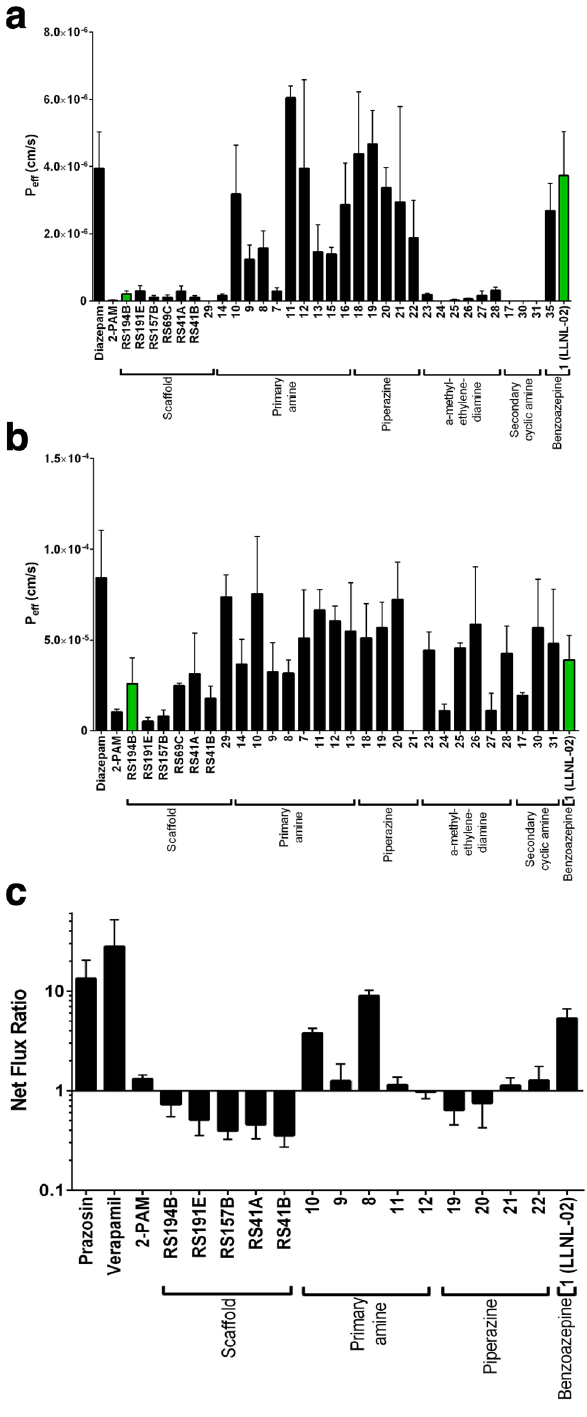
Figure 4. In vitro diffusion and transcellular permeability of oxime candidates. LLNL-02 ( 1 ) demonstrated moderate diffusion and permeability at levels between that of RS-194B and diazepam. ( a ) The PAMPA system was applied to examine degree of passive diffusion for each compound. Results showed a range of permeability across tested compounds and indicate elevated permeability of LLNL-02. Compounds with quantities in acceptor wells below the UPLC limit of detection are shown as zero. ( b ) A HCMEC monolayer was applied to examine transcellular diffusion across an in vitro representation of the brain endothelium. Results for compound 21 were below the limit of detection for this assay system. Compounds 22 , 15 , 16 , and 35 could not be solubilized and successfully formulated in culture media, and thus were omitted from analysis by this platform. Diazepam is shown as a positive control for permeability. ( c ) The in vitro MDR1-MDCK assay system was applied to assess substrate specificity for efflux by p-gp, for a select subset of compounds. Net flux ratio (NFR) greater than one indicates that a compound may be a possible substrate. Prazosin and verapamil are shown as a positive control for efflux substrate specificity. Compound chemical class is shown below the horizontal